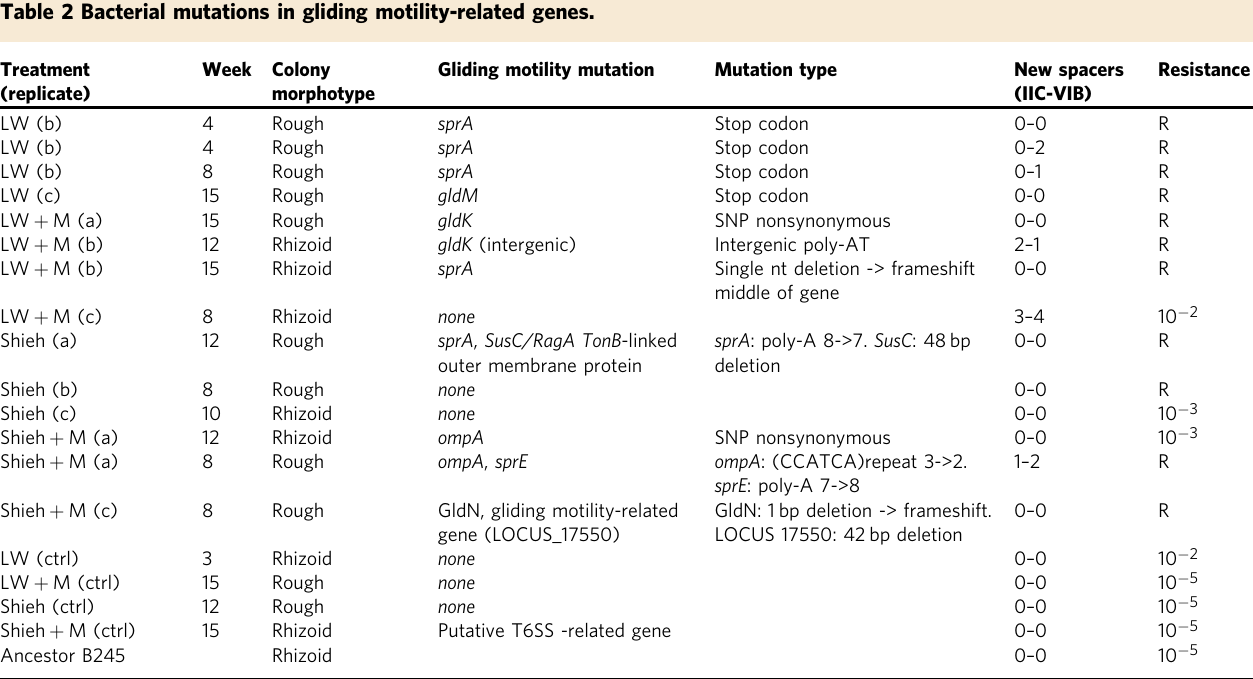
Table 2 Bacterial mutations in gliding motility-related